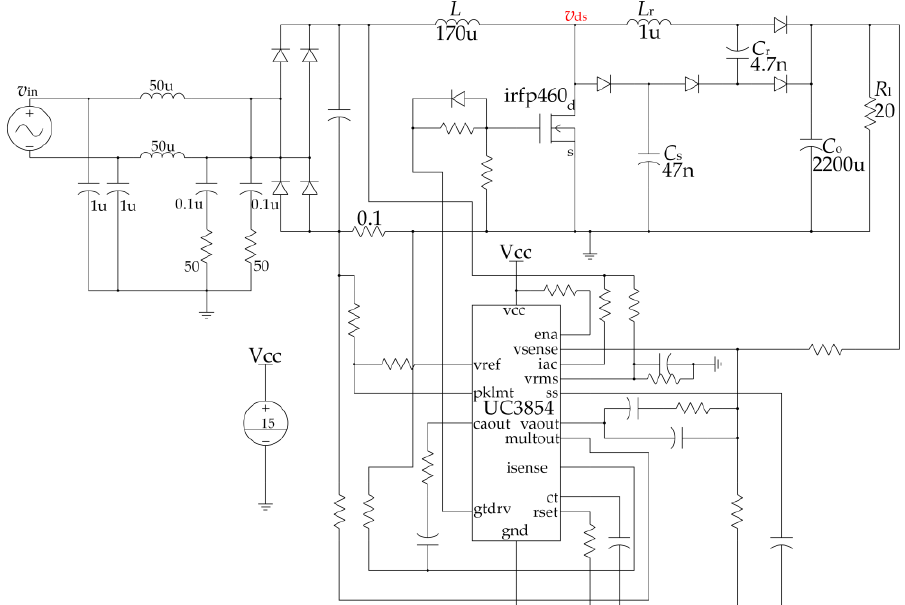
Figure 6. Boost PFC converter simulation circuit.